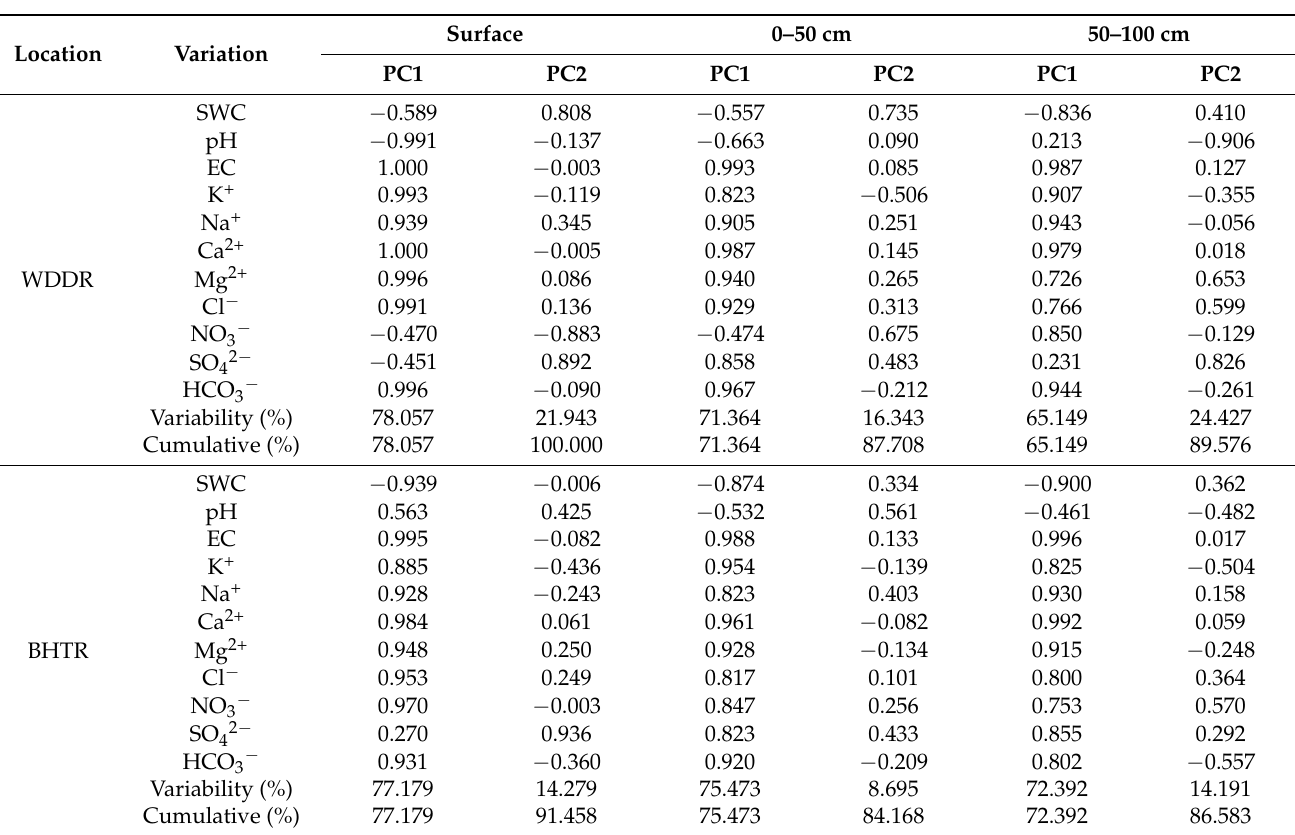
Table 3. Physical and chemical parameters on two significant principal components for soil-soluble salt at different depths in the study